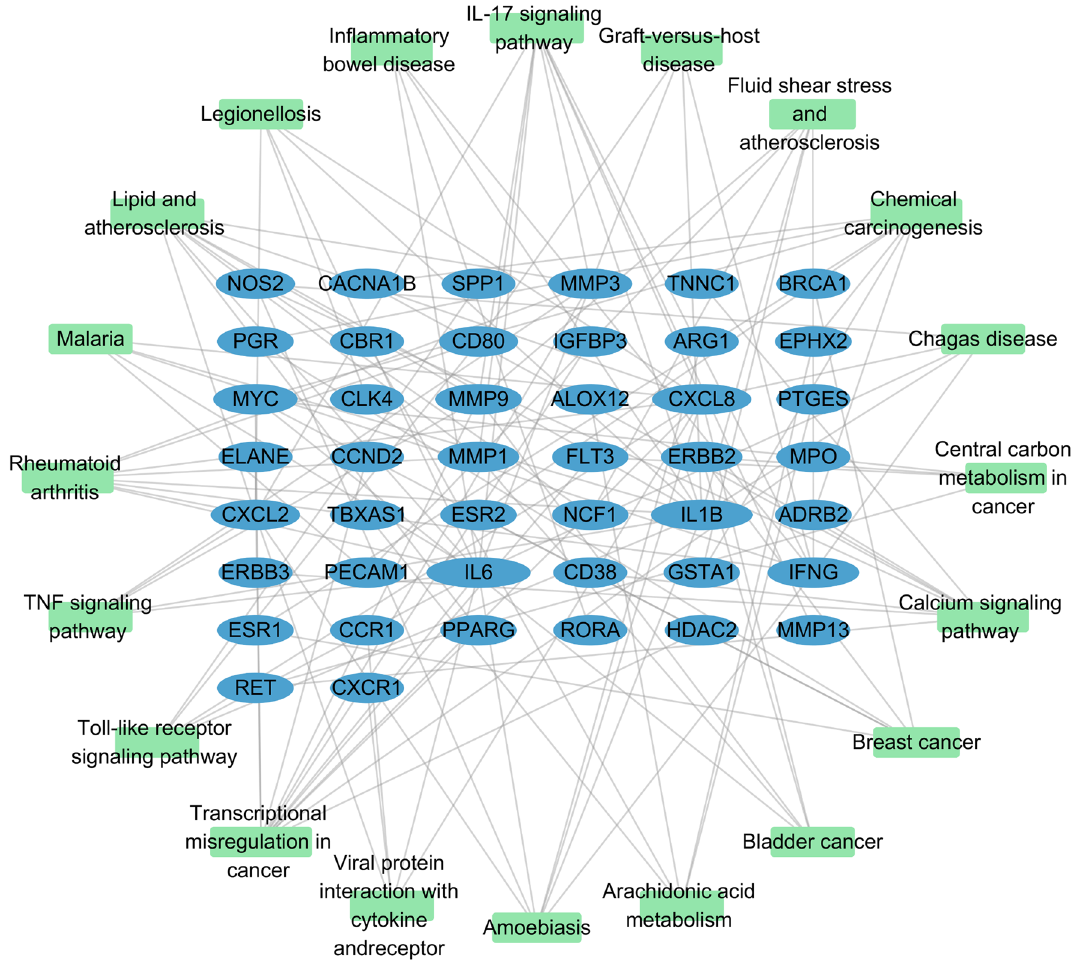
Figure 6. The target–pathway network implicated in the mechanism of PCRER in Peri-implants treatment. The green nodes represent the pathways, represent the interaction between the pathways and the targets, whereas the lake blue nodes represent the targets involved in these pathways is proportional to the degree of interaction.